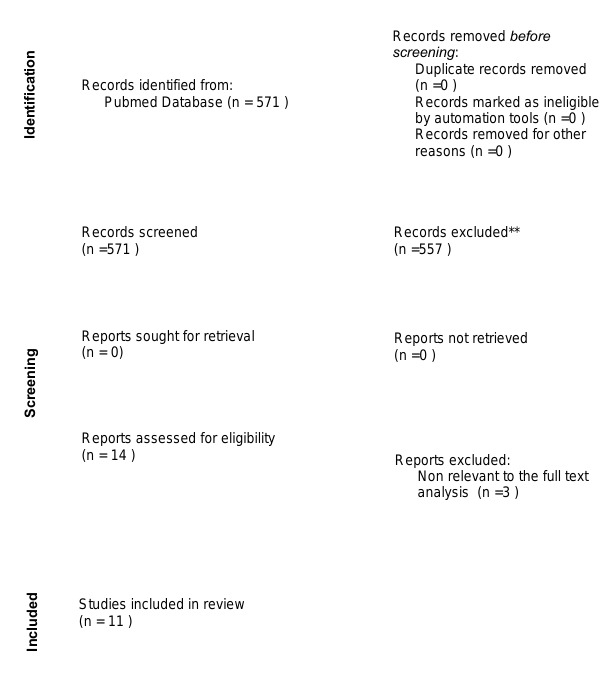
Figure 1. Flow diagram of the search strategy.